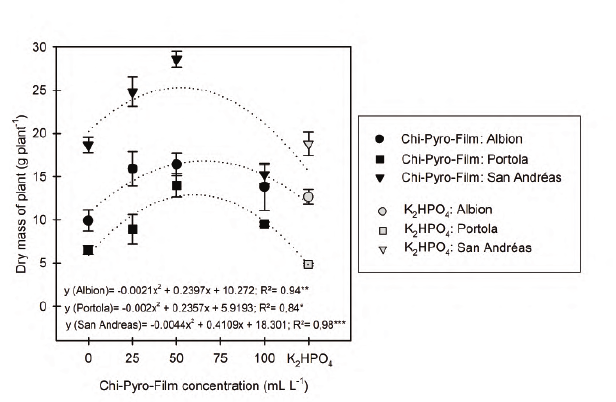
Fig. 3 ­ Dry mass of leaves of Albion, Portola and San Andreas cultivars, in response to Chi­Pyro­Film concentrations and reference treatment (K effect between factors (cultivar and film concentration). *, **, ***, significant at p<0,05, p<0,01, p<0,001, respec­